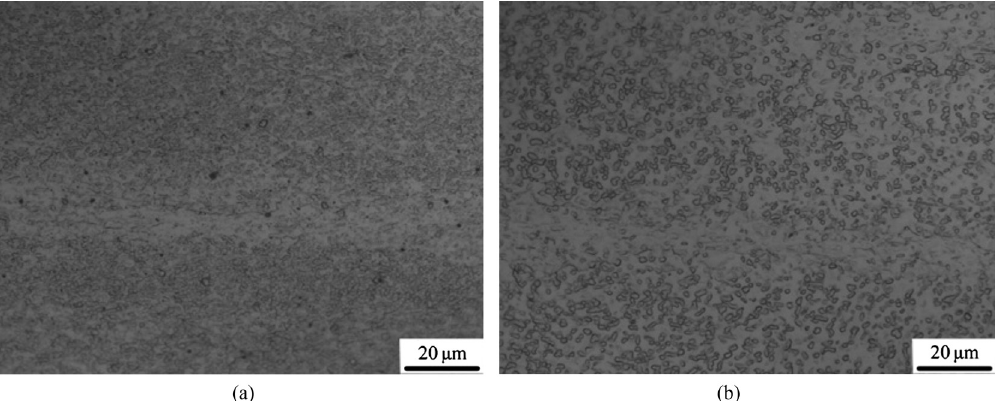
Figure 6 The microstructure of as-forged Ti-10V-2Fe-3Al alloy at different deformation